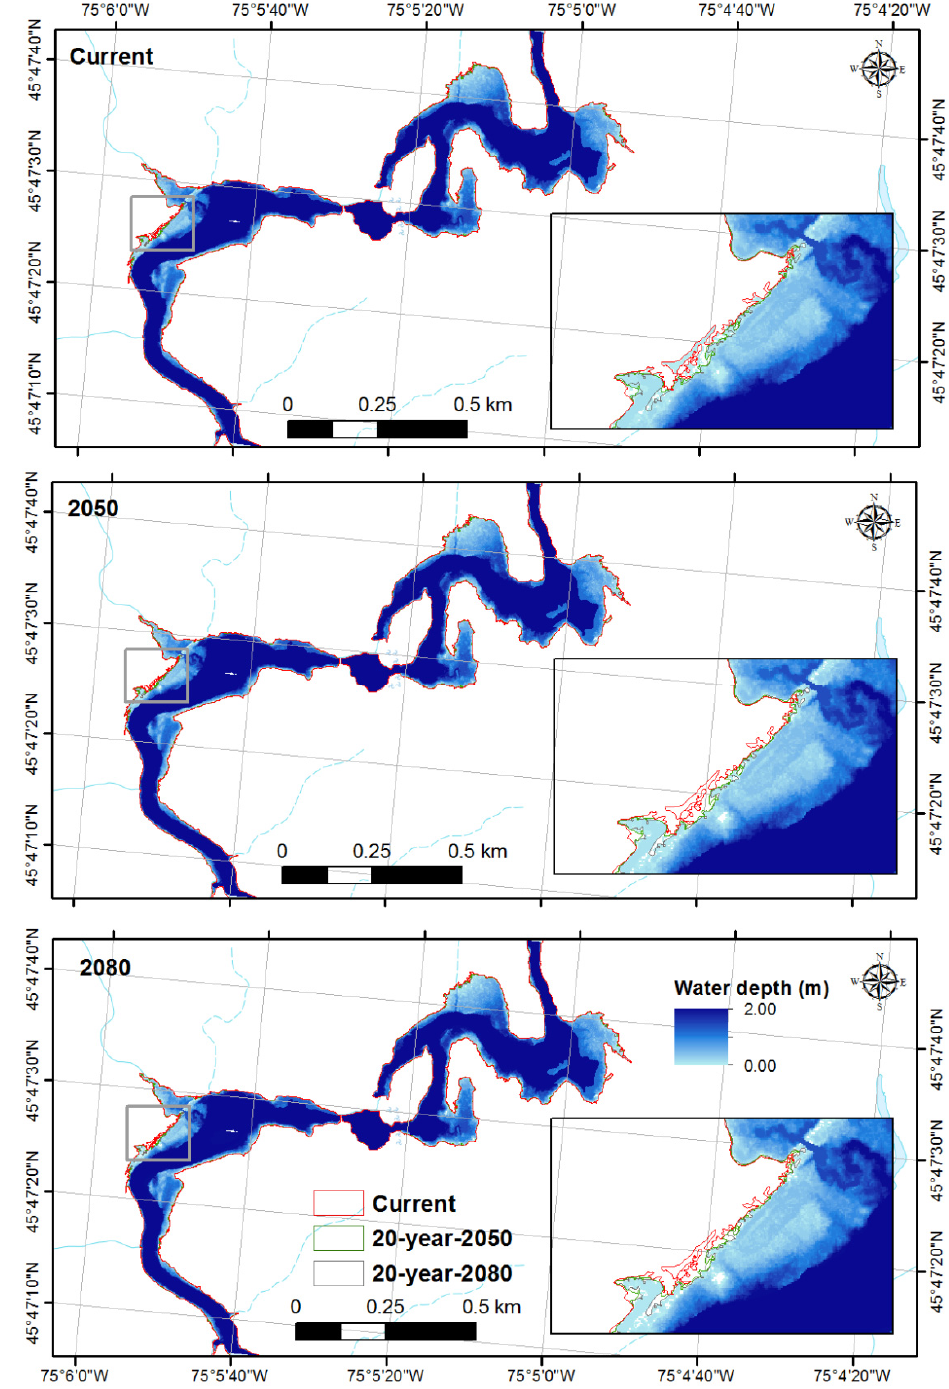
Figure A5. Projected flood depth for a 20-year return period (RCP 8.5). Case: Ripon.